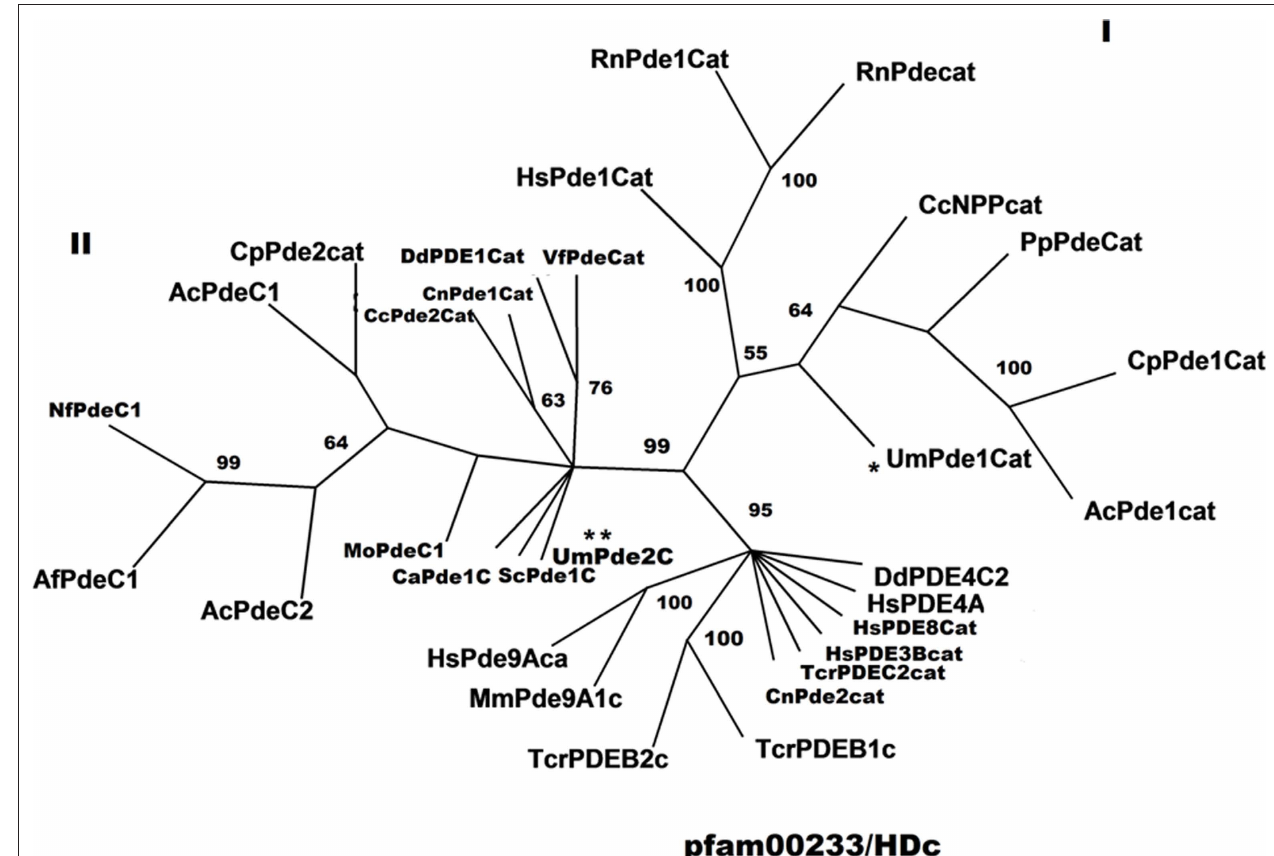
Figure 5 | Phylogenetic analyses for a variety of PDes. This is an unrooted Phyl-ML tree from analysis of the catalytic domains of PDEs by Phylip as part of the seaview package of phylogenetic software (Gouy et al., 2010), employing the WAG model for ML analysis. Support for major branches is indicated from a tree showing the same topology, but generated by phylogenetic analysis in PAUP4.0b10 using a Full Heuristic search with Bootstrap analysis of 1000 replicates. The species abbreviations, NCBI or MUMDB (for the U. maydis PDEs) accession numbers, residues used, and taxonomy are: UmPde1Cat, Ustilago maydis , um02531, 120-465, Fungi, Basidiomycota; UmPde2Cat, U. maydis , um10895, 240-345, Fungi, Basidiomycota; CcNPPcat, Coprinopsis cinerea okayama7#130,